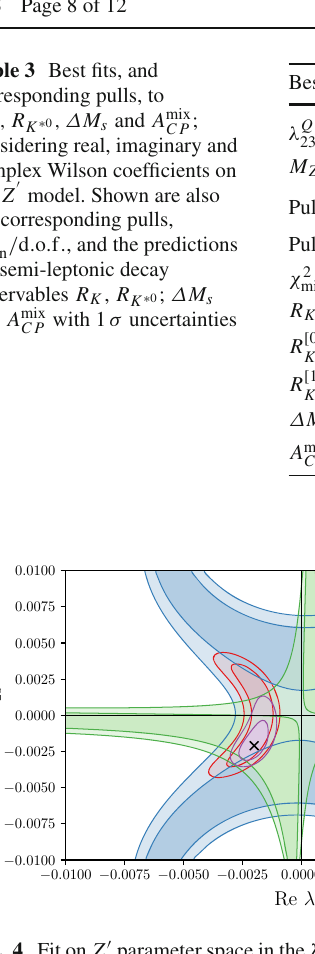
complex plane for the best 23